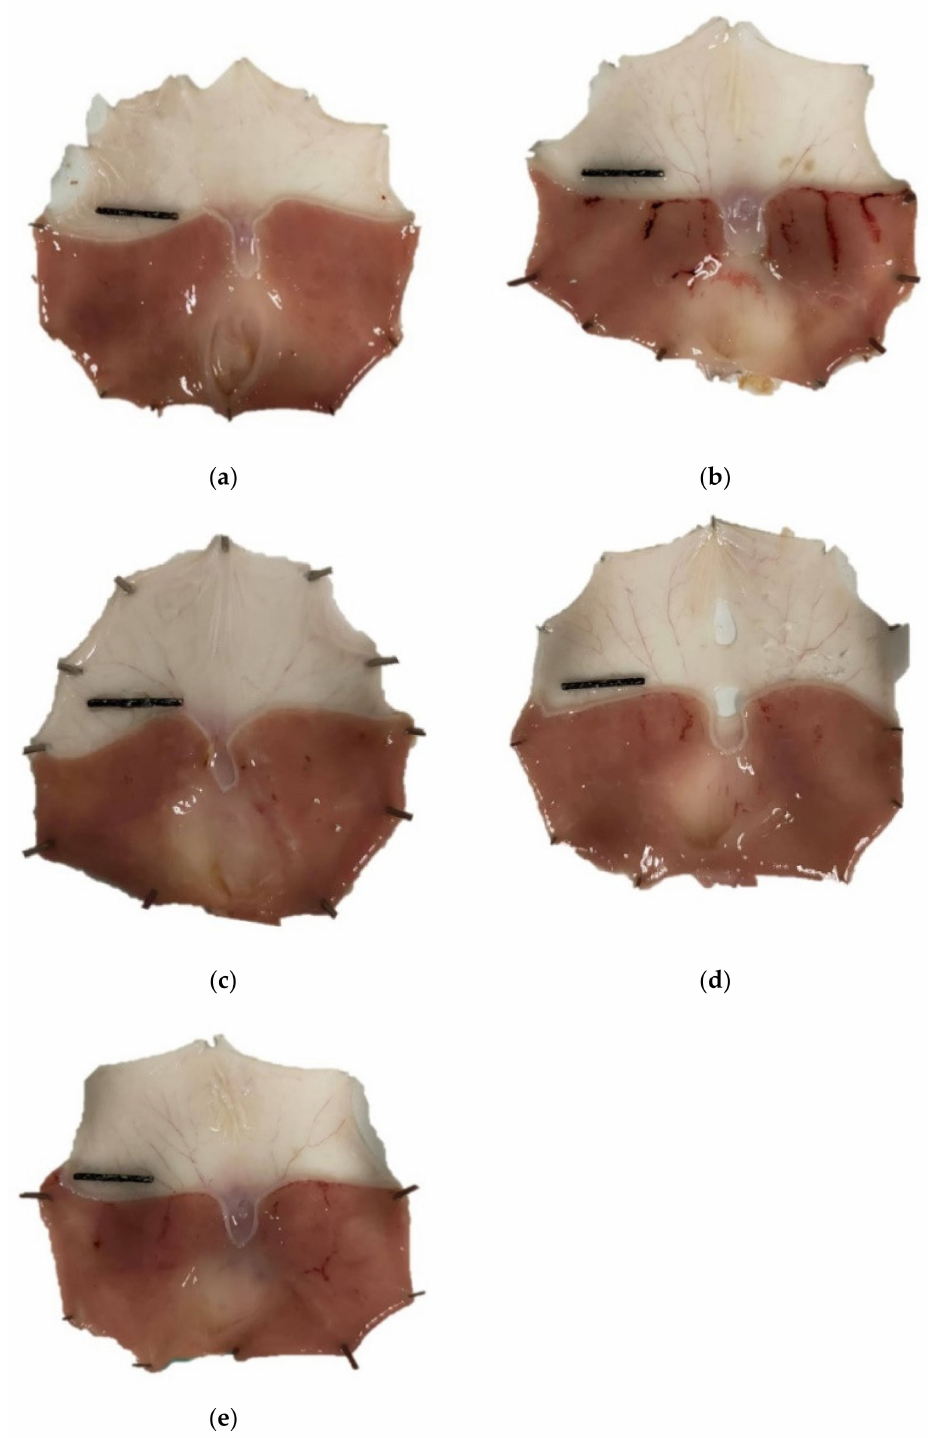
Figure 1. Effects of OMZ and Phy-Blica-D on the gross appearance of the gastric mucosa in ethanol- induced gastric ulcers in rats. ( a ) Normal group; ( b ) vehicle group; ( c ) OMZ group (20